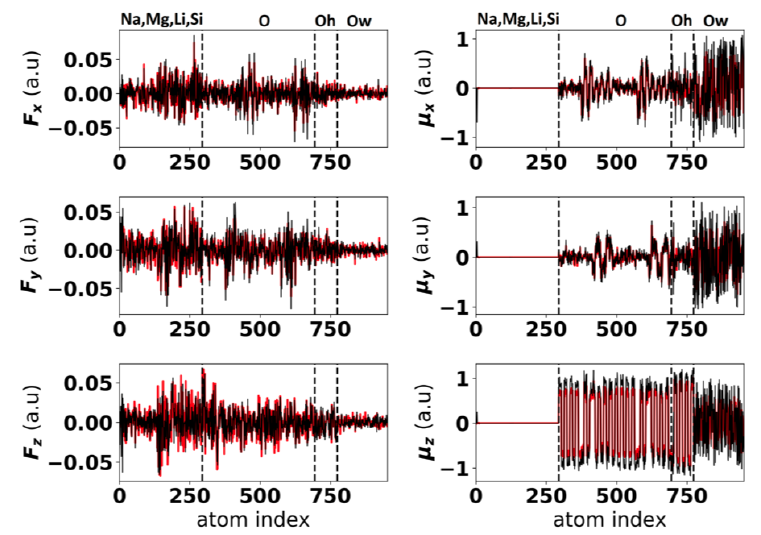
Figure 2. Forces for each atom for one of the hydrated hectorite configurations. The predictions of the classical force field (black lines) for the force ( F x , F y and F z ) and dipole ( µ x , µ y and µ z ) components are compared to the DFT results (red lines). The atom indices are grouped by atoms types: cations (Na, Mg, Li, Si), clay oxygen atom (O), clay oxygen atoms in hydroxyl groups (Oh) and water oxygen atoms (OW). The groups are delimited by the dashed